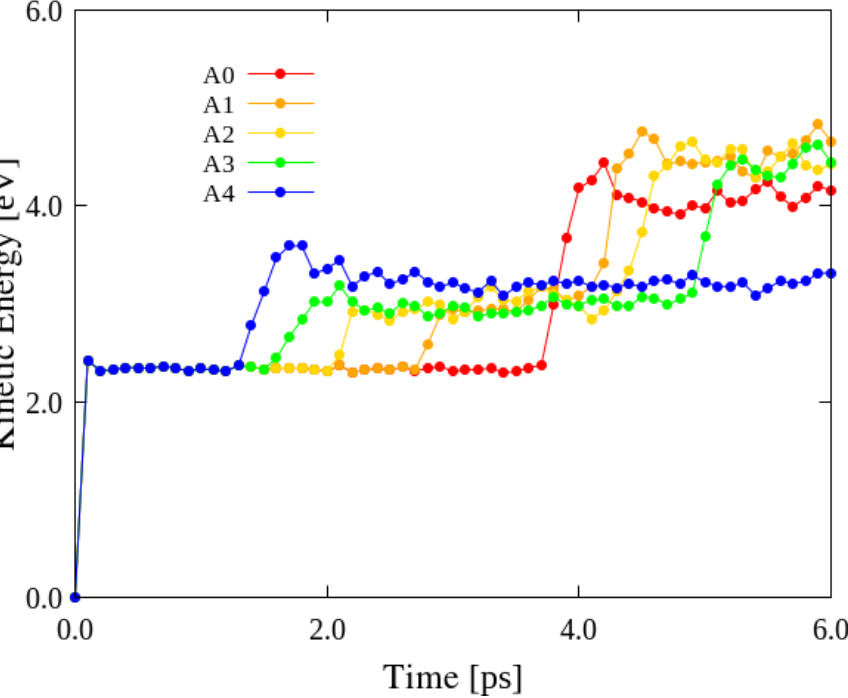
Figure 6. Comparison of KEs of the wavy4 GS model impacted by C 60 at 𝑣 (cid:2890)(cid:2868) = 10 Å/ps at the A0, A1, A2, A3, and A4 sites.